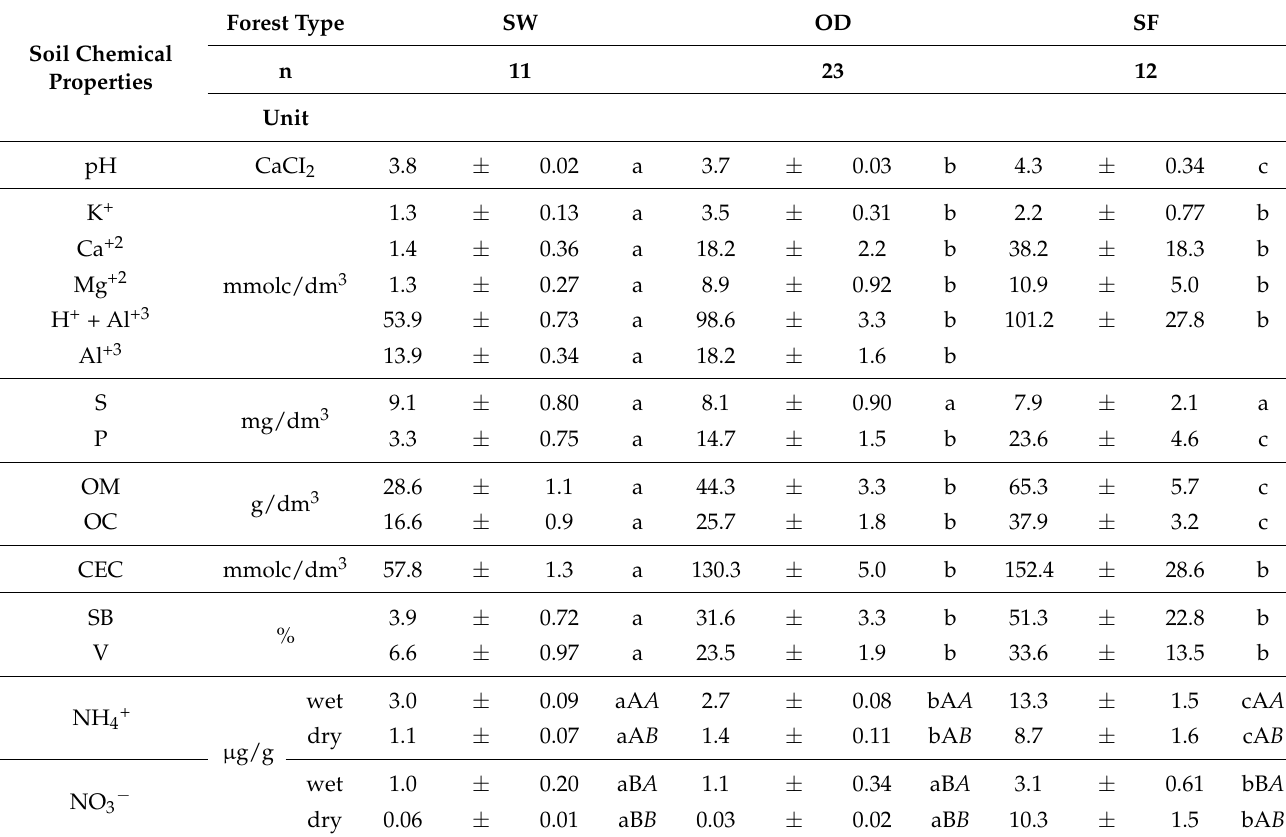
Table 2. Soil chemical properties in three types of tropical forest: Savanna Woodland (SW), Ombro- phylous Dense (OD), and Semideciduous Forest (SF). Values are the mean ± standard error for n samples of each forest type. Means are followed by letters, where lowercase letters indicate significant differences between forest types, uppercase letters indicate significant differences between inorganic N forms (NO 3 − vs. NH 4+ ) in the same season, and uppercase letters in italics indicate significant differences between the same inorganic N forms by season (ANOVA and a post hoc Tukey’s HSD post hoc test, α = 0.05). Abbreviations: OM—Organic Matter, OC—Organic Carbon, CEC—Cation Exchange Capacity, SB—Base Saturation and V—Percentage of Saturation by